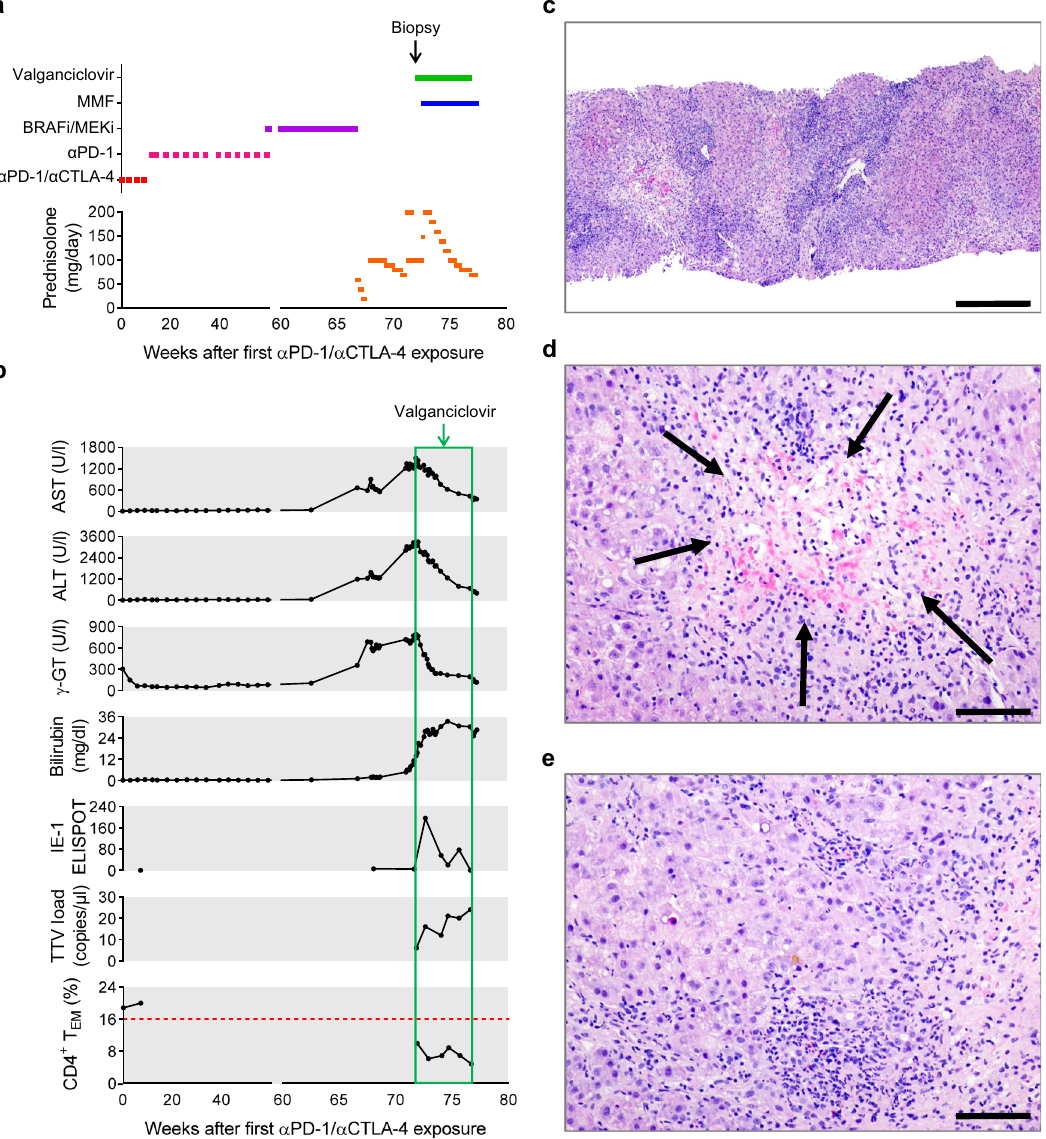
Fig. 8 Case 2: valganciclovir treatment of late-onset α PD-1/ α CTLA-4-related hepatitis. A 49-year-old male patient who received α PD-1 (Nivolumab) plus α CTLA-4 (Ipilimumab) dual therapy for metastatic melanoma presented with late-onset hepatitis. a Course of treatment. b Change in hepatitis-related parameters over time and their association with introduction of valganciclovir treatment. c Histopathological image of a liver biopsy taken at the start of week 72 showing signs consistent with drug toxicity, autoimmunity or viral infection (H&E staining; scale bar 500 µ m). d Extensive centrilobular necrosis (arrows) involving 30 – 40% of hepatocytes was observed (H&E staining; scale bar 100 µ m). e Dense in fl ammatory in fi ltration of lymphocytes, eosinophils and neutrophils was seen in portal areas (H&E staining; scale bar 100 µ